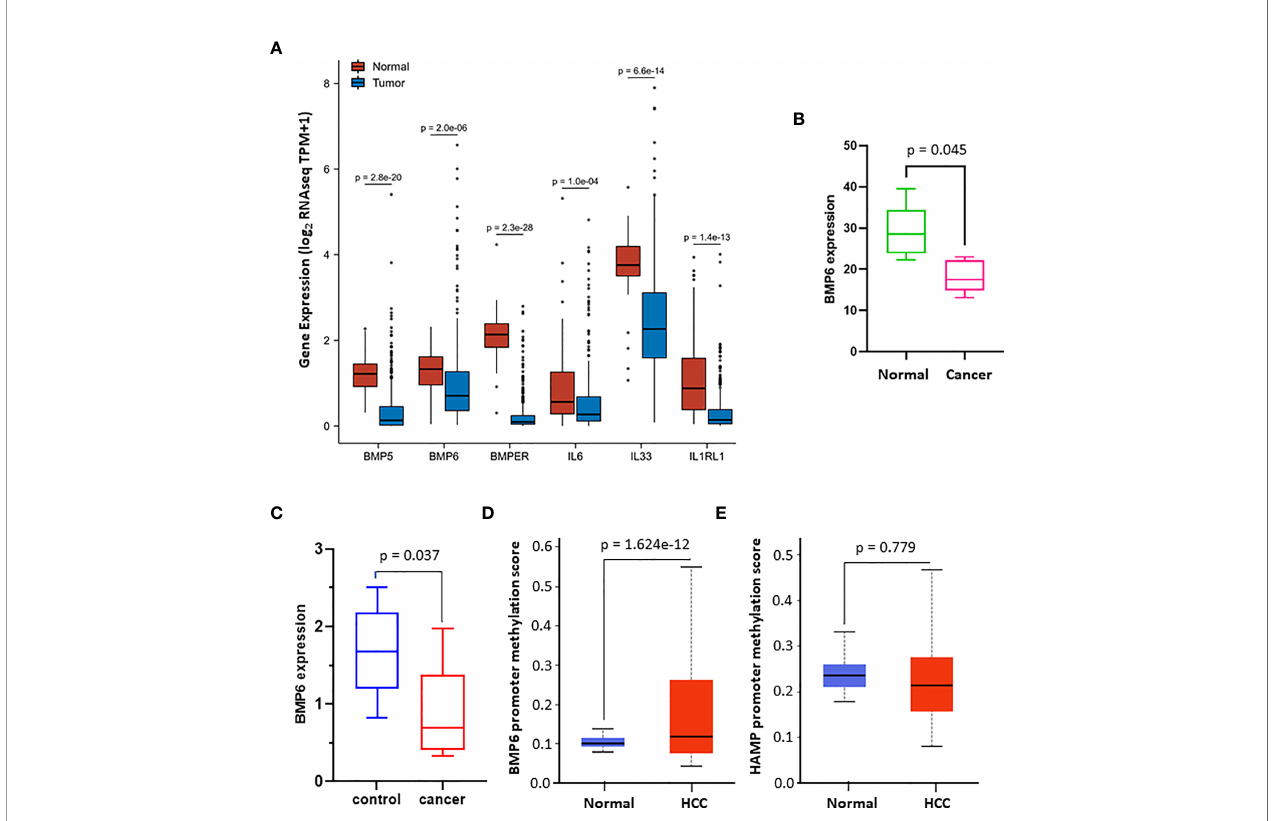
FIGURE 5 | Hepcidin expression is positively associated with iron regulation-related genes. (A) Gene expression pro fi les were analyzed using the TCGA dataset on the XIANTAO platform (424 liver cancer cases, 50 benign liver tissues). The p-value was from a Wilcoxon rank-sum test. (B) BMP6 gene expression data were downloaded from GEO dataset GDS2006, which was generated from the thioredoxin interacting protein-de fi cient mice with spontaneous liver cancer (30). BMP6 expression levels were normalized with the ACTB gene levels as an internal control (n = 3). The p-value was from a Student t -test. (C) BMP6 gene expression data were downloaded from the GEO dataset GDS1385, which was generated from a rat liver cancer model induced by long-term feeding of choline-de fi cient/L-amino acid-de fi ned diet (31). BMP6 expression levels were normalized with the ACTB gene levels as an internal control (n = 3). The p-value was from a Student t -test. (D, E) Promoter DNA methylation was analyzed using the TCGA dataset (n = 424) on the UALCAN platform (32). The p-value was from a Student t